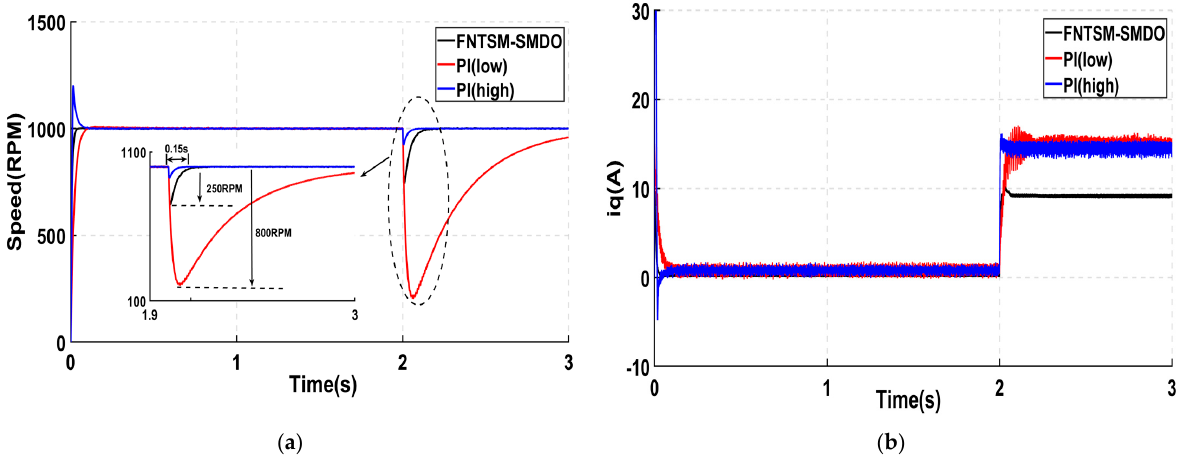
Figure 6. ( a ) Speed curve under an unmatched disturbance, ( b ) q -axis current curve under an un- matched